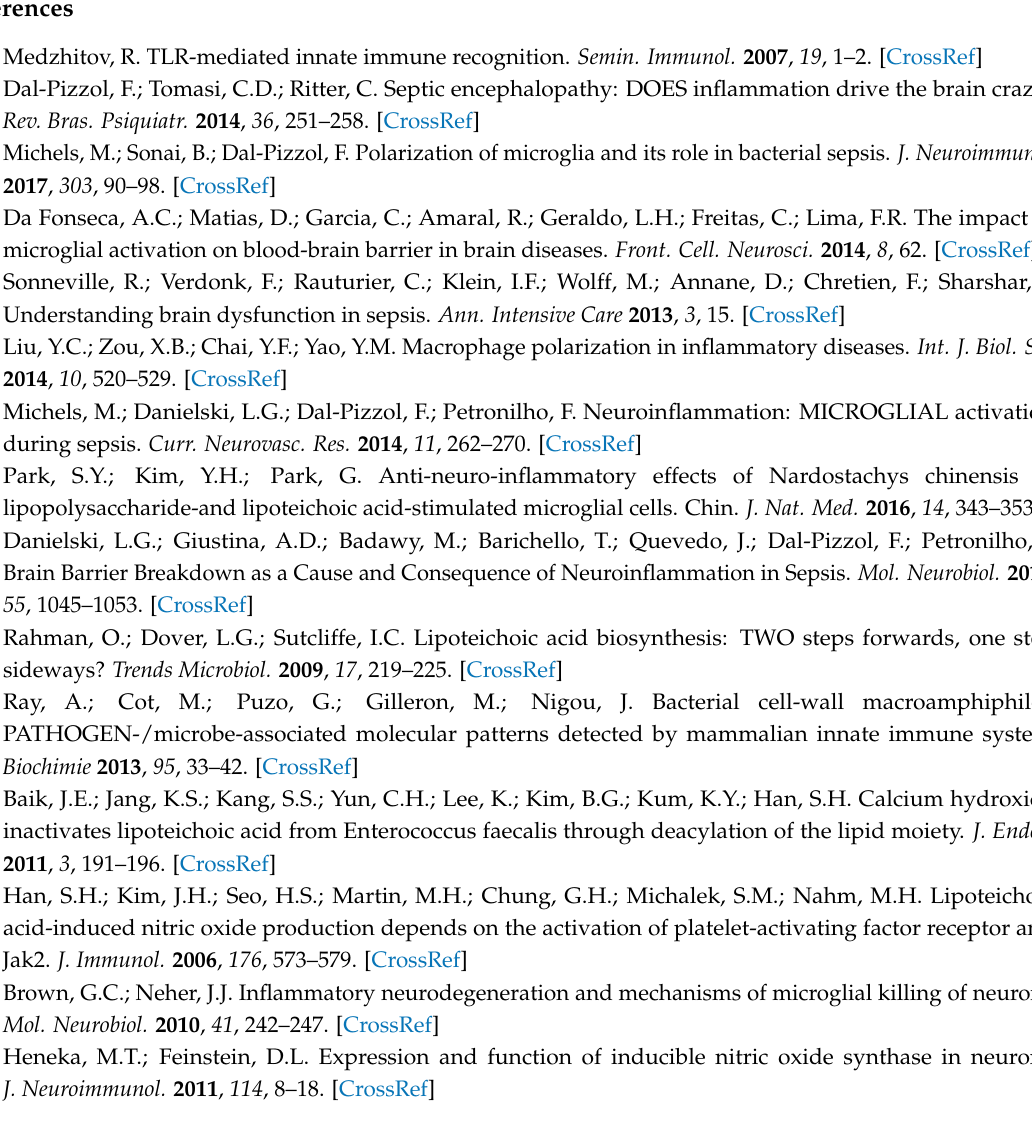
Supplementary Materials: Figure S1: Optical densities of the western blot analyses of DMT-1 (A,B), TfR1 (C,D), FTH (E,F), and FTMT (G,H) of mono- and co-cultured SH-SY5Y cells. The analyses were made using ImageJ software (https://imagej.nih.gov/ij/), the optical density of the examined proteins was expressed as percentage of target protein/ β -actin abundance. Asterisk marks p < 0.01 compared to untreated controls. Figure S2: Optical densities of the Western blot analyses of p-STAT3 of mono- (A) and co-cultured (B) SH-SY5Y cells. The analyses were made using ImageJ software (https://imagej.nih.gov/ij/); the optical density of p-STAT3 was expressed as percentage of target protein/ β -actin abundance. Asterisk marks p < 0.01 compared to untreated